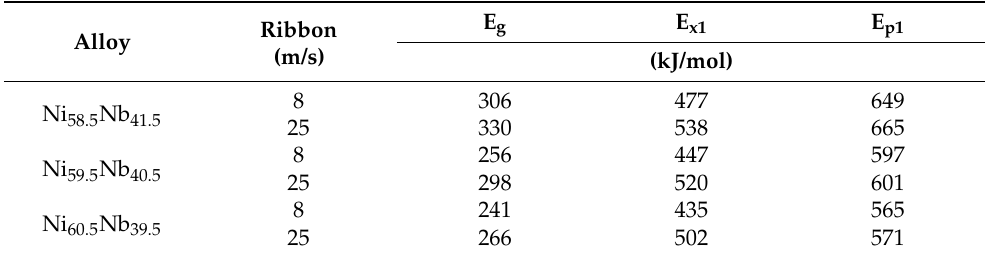
Table 3. Activation energies E g , E x1 and E p1 for the crystallization of Ni 58.5 Nb 41.5 , Ni 59.5 Nb 40.5